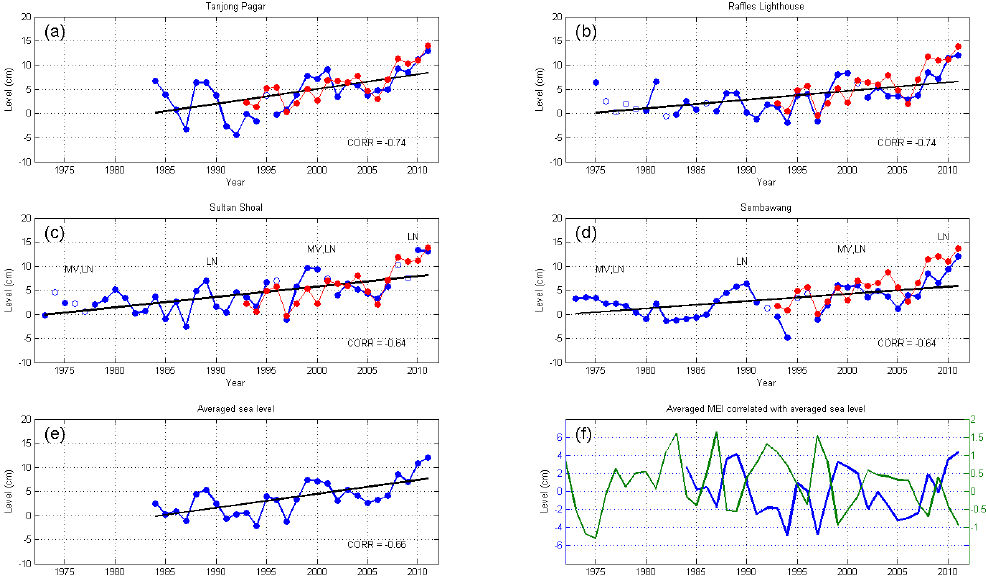
Fig. 4. (a–e) Sea level at tide gauges in Singapore Strait (the zero reference level is adjusted to the beginning of the regression line): blue dot-line identify annual sea level at the tide gauges, with linear trend for the observation period identified by solid black lines; open blue circles indicate restored missing data; correlation of sea level and Multivariate ENSO Index (MEI) is shown for each tide record; red dot-line identify satellite altimetry for the SS region (AVISO). (f) Comparison of anomalies of average annual SS sea level (detrended, blue line) with yearly-averaged MEI (green line). Periods of sea level maxima due to multi-decadal variability and La Ni˜na episodes are indicated by symbols “MV” and “LN”,